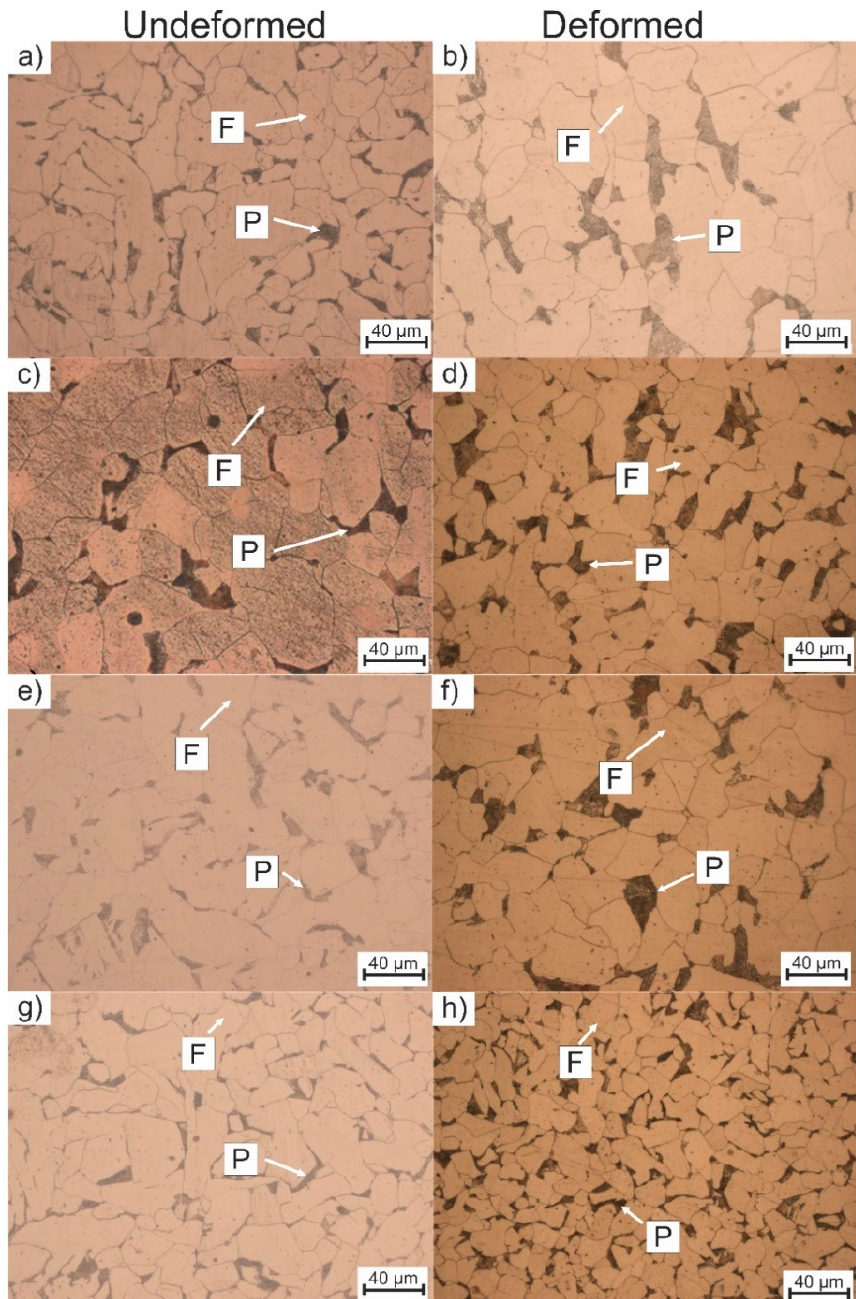
Figure 6. Microstructures of non-deformed and deformed samples at different cooling rates: ( a , b ): 0.125 °C/s, ( c , d ): 1 °C/s, ( e , f ): 2 °C/s, ( g , h ): 4 °C/s.